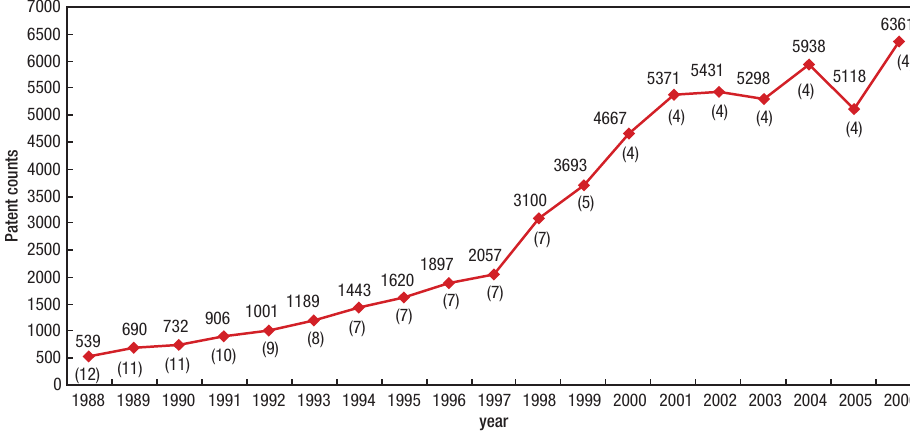
Fig. 1. Taiwan’s patents approved in the U.S.,